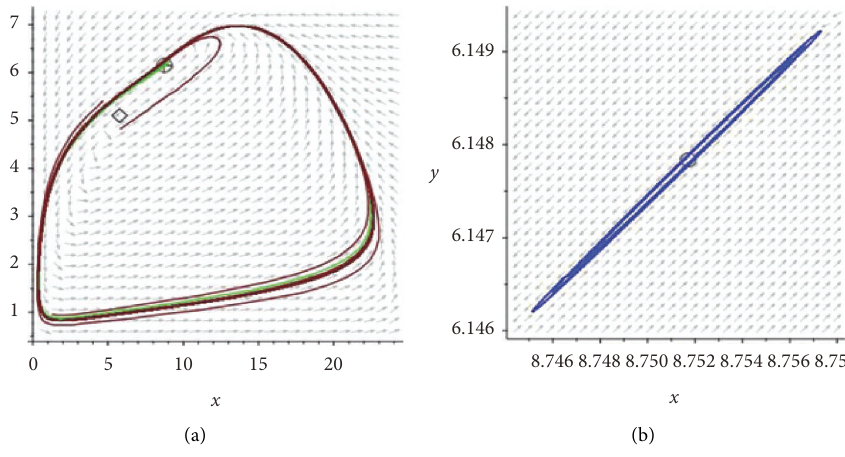
Figure 12: Phase diagrams in case (v).